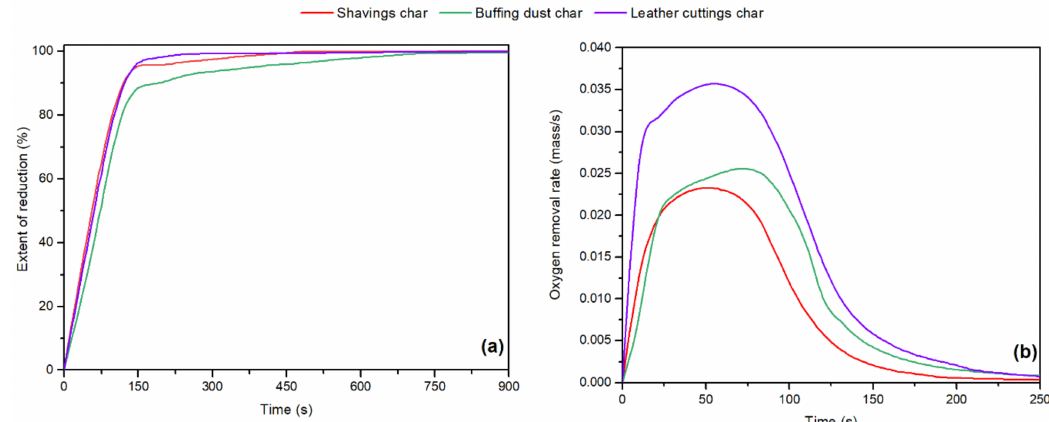
Figure 11. ( a ) Extent of reduction and ( b ) oxygen removal rate of iron oxide with the chars produced from chromium-containing leather wastes (Adapted from Nur-A-Tomal, et al. [7]. Reproduced with permission from Springer Nature).